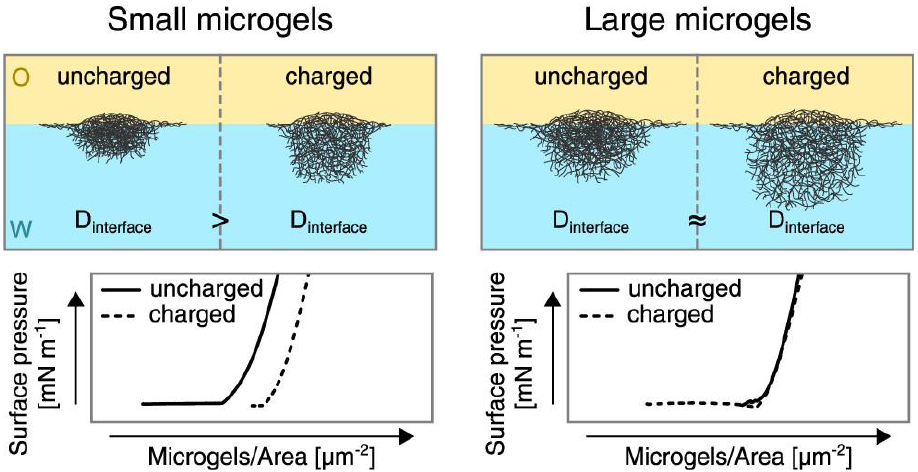
Figure 5. Effect of the size and charge of microgels adsorbed at a water/oil interface on the in-plane organization of the microgel film as a function of the diameter of the projection of the particle at the interface ( D interface ). Reproduced from Schmidt et al. [76] with permission from the Royal Society of Chemistry, Copyright (2020).